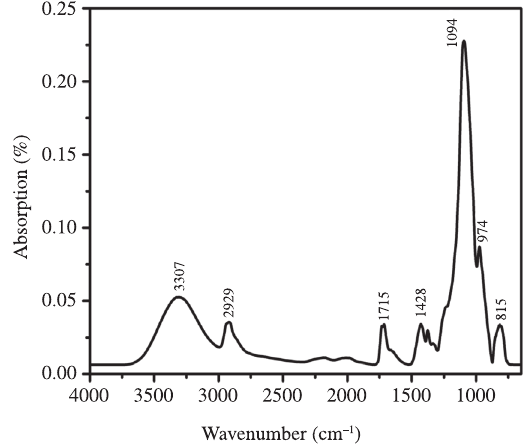
Figure 6. FTIR spectra of electrospun PVA fibers. Figure 7. FTIR spectra of electrospun PVA/SiO